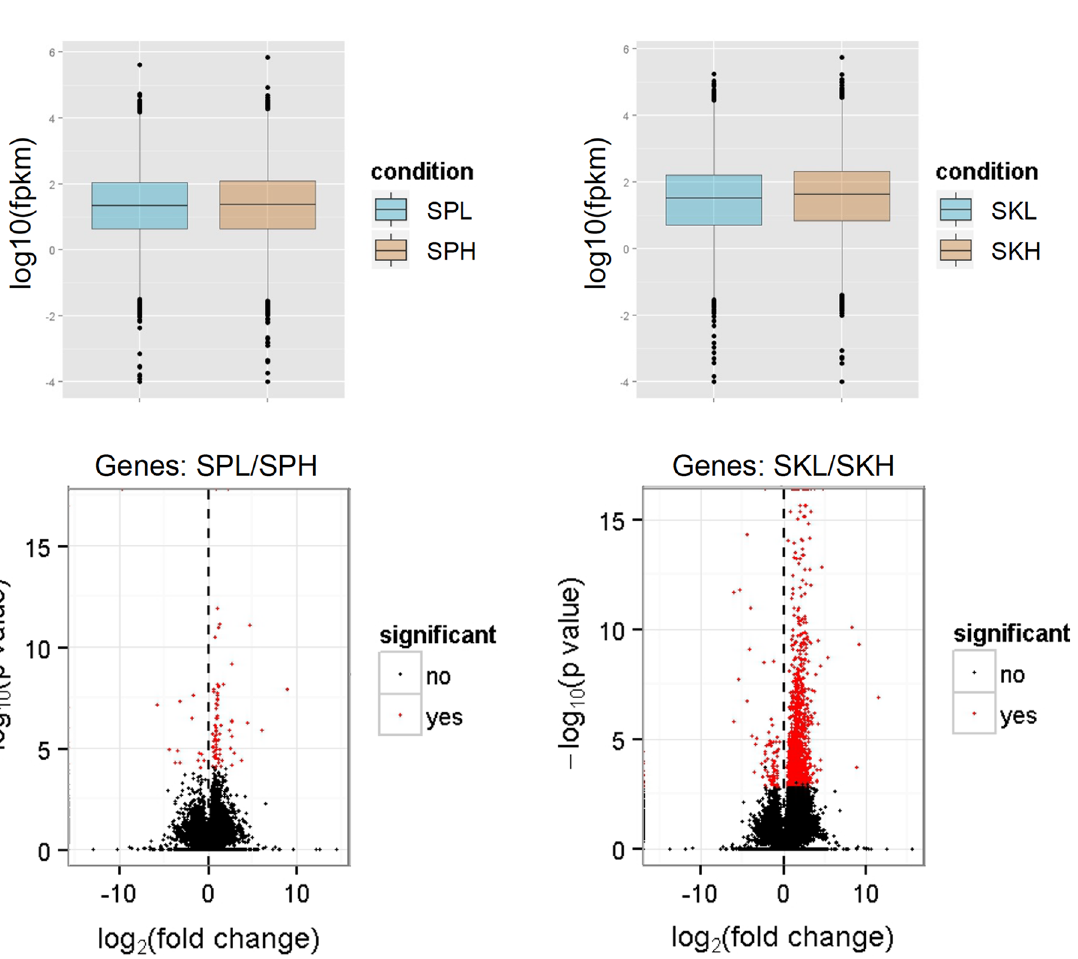
Fig 1. Summary of RNA-seq data from spleen and skin samples from animals displaying extreme IR. (A) Box plot showing the distribution of fragments per kilobase of exon per million fragments mapped (FPKM) values. (B) Volcano graph showing differentially (in red) and non-differentially (in black) expressed genes. Values of > 0 correspond to down-regulated genes, while values of < 0 correspond to up-regulated genes. SPL, spleen low IR; SPH, spleen high IR; SKL, skin low IR; SKH, skin high IR.